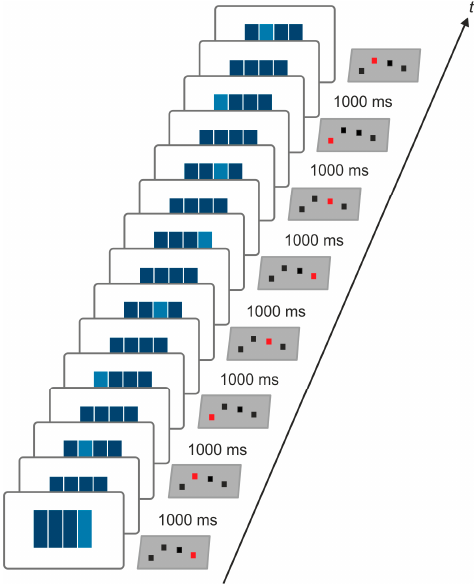
Figure 2. Serial reaction time task (SRTT). The SRTT is realized by four horizontally aligned bars presented on a screen in front of the participants. The figure exemplifies one of the three sequences applied in the present study. Each bar corresponded to one button of a custom-made response box, which was connected to a standard windows PC. The participants were instructed to respond as fast and as accurately as possible by button press with the right hand as soon as one bar changed its color. Each correct response was followed by a fixed interval of 1000 ms.